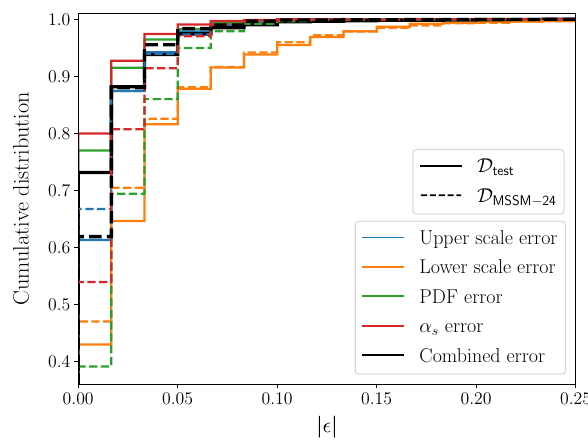
Fig. 9 Cumulative distribution of the relative error magnitude for the upper and lower scale errors, the PDF error and the α s error for the gluino pair-production